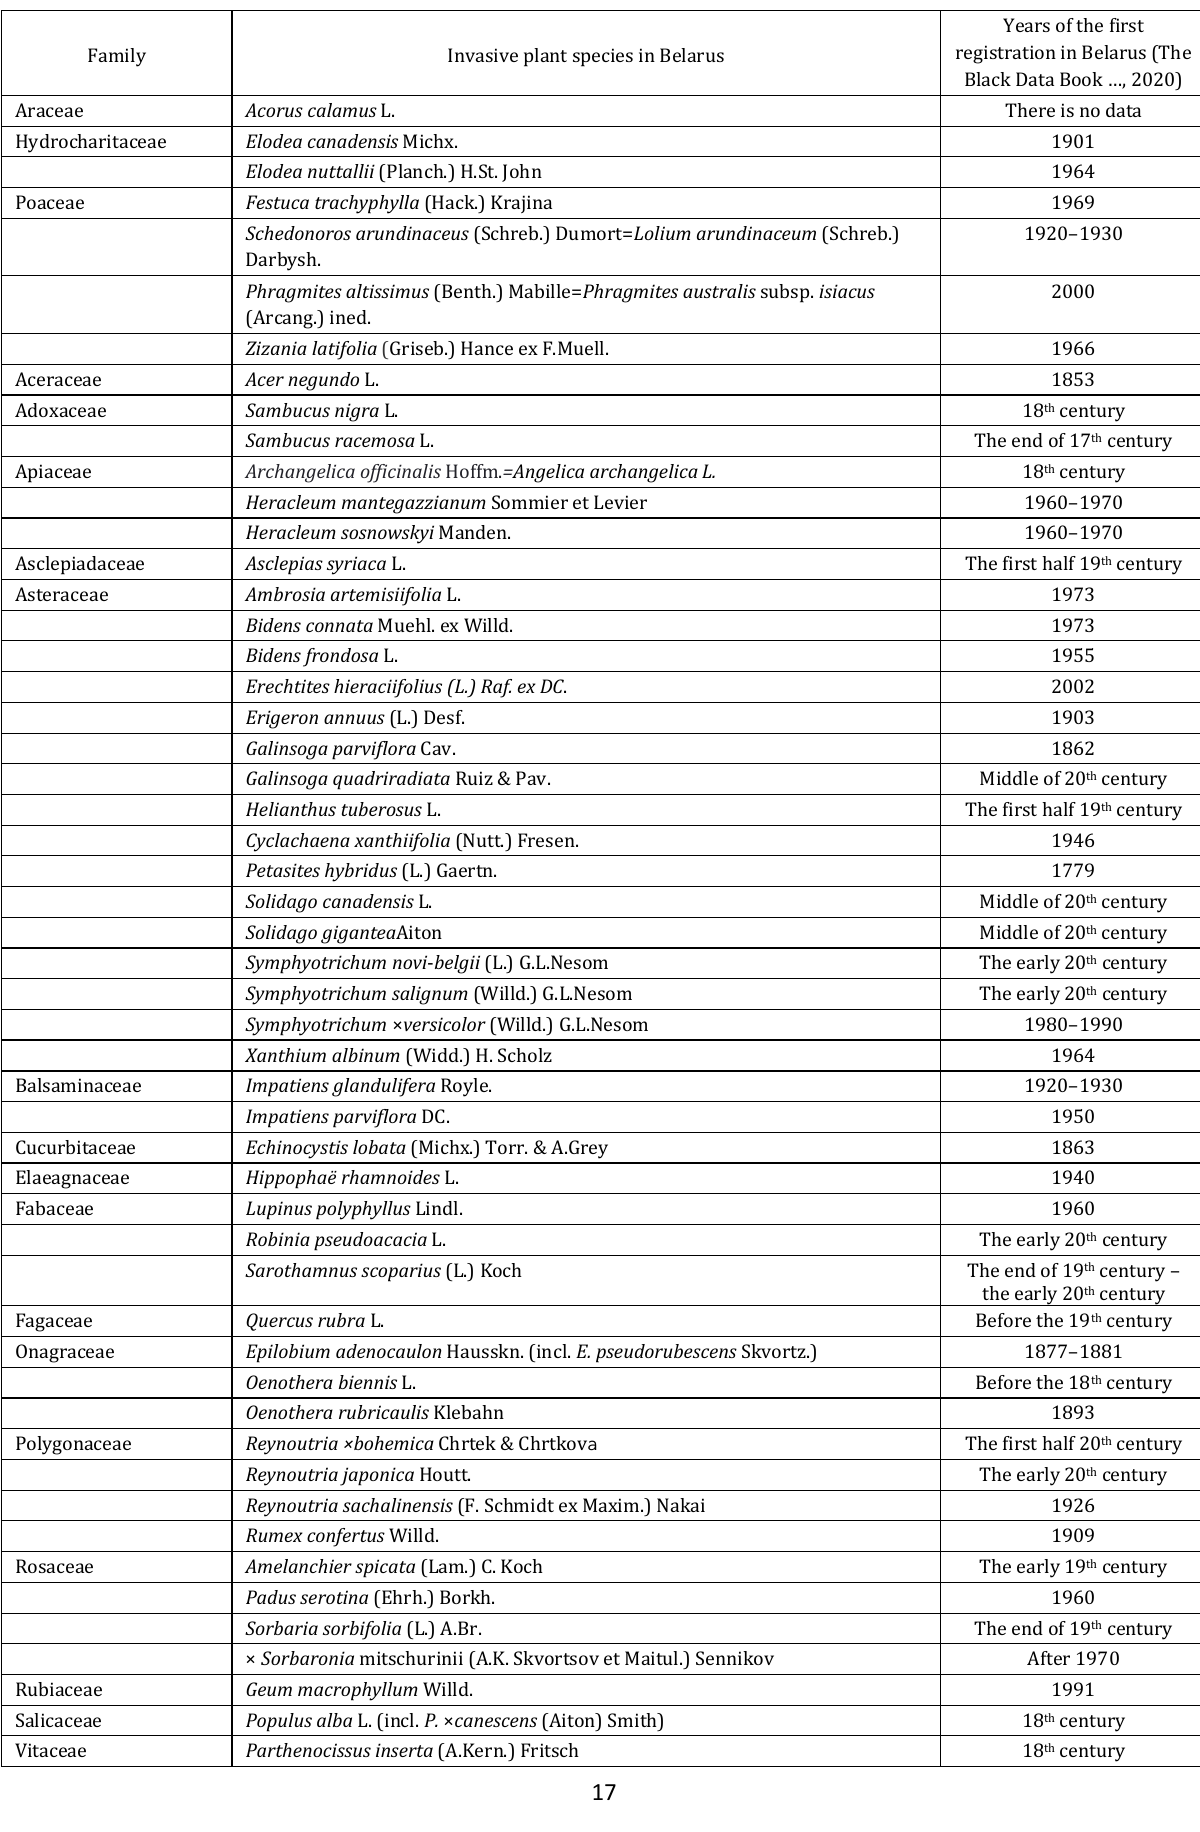
Table 1. List of the invasive alien plant species and the time of their first registration in Belarus